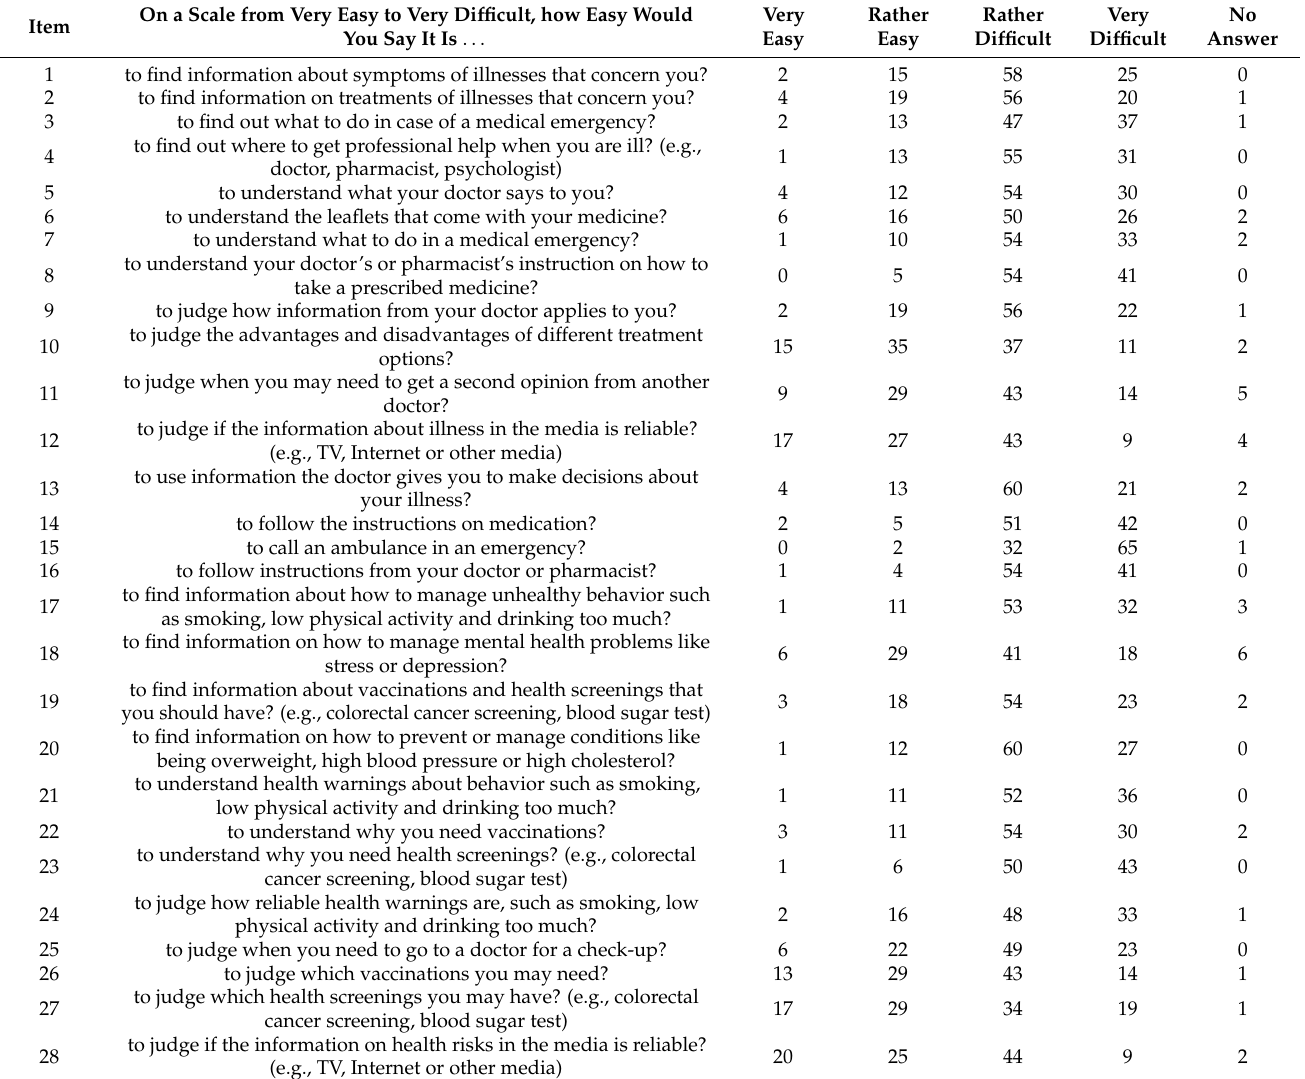
Table A1. HLS-EU-Q47 items by responses of the sample